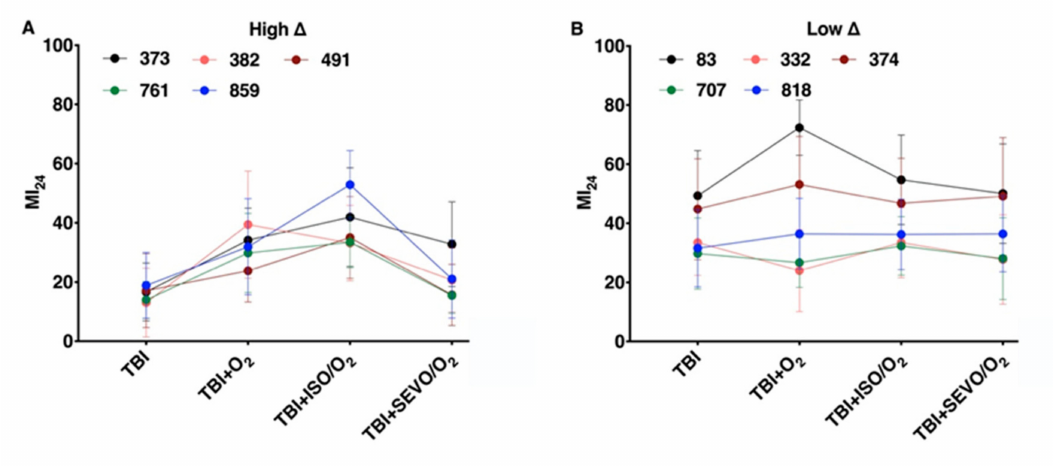
Figure 3. The response of a fly line to ISO / O 2 exposure following TBI does not always predict its response to O 2 or SEVO / O 2 exposure. Colored dots and error bars indicate the average and standard deviation, respectively, of the MI 24 for three independent samples of individual RAL lines under the indicated treatment conditions. ( A ) High ∆ lines and ( B ) low ∆